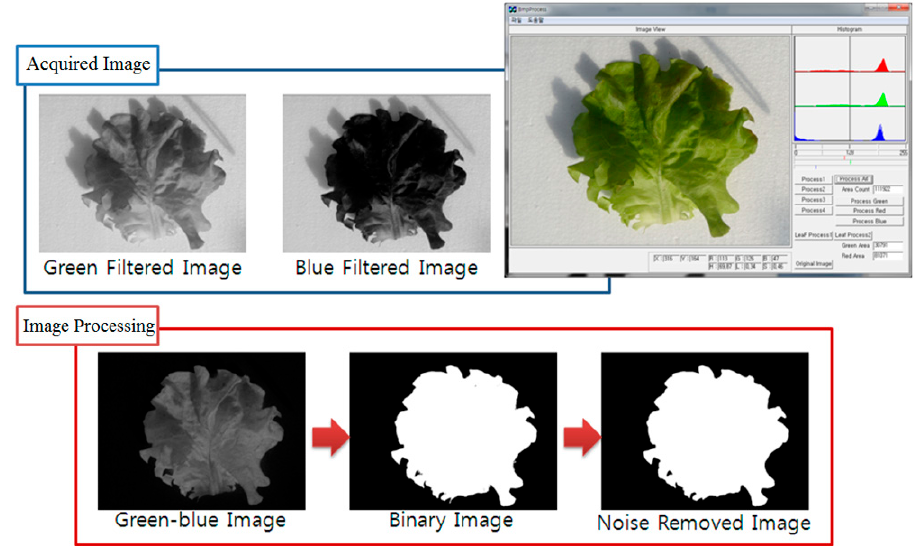
Figure 12. The image processing program and processed image.